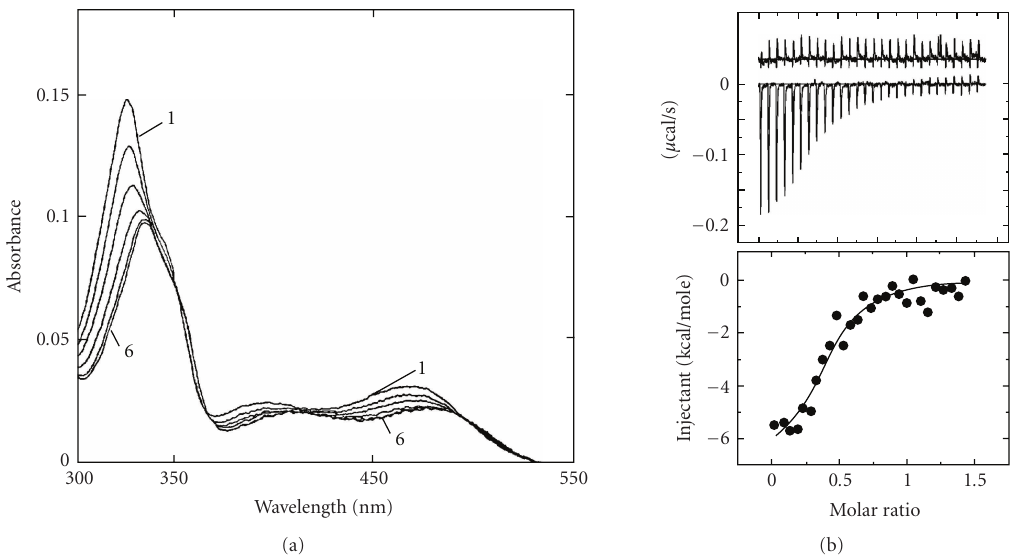
Figure 7: (a) Absorption spectrum (1) of sanguinarine (4.9 μ M) with increasing concentrations up to 54.8 μ M (10) of calf thymus DNA. Reprinted from the PhD Thesis of A. Das [71]. (b) The ITC profiles for the binding of sanguinarine (100 μ M) to Calf thymus DNA (15 μ M). The lower panel represents the corresponding normalized heat signals versus molar ratio. The data points reflect the experimental injection and the solid line represents the best fit of the data. Reprinted from the Ph.D. Thesis of Hossain